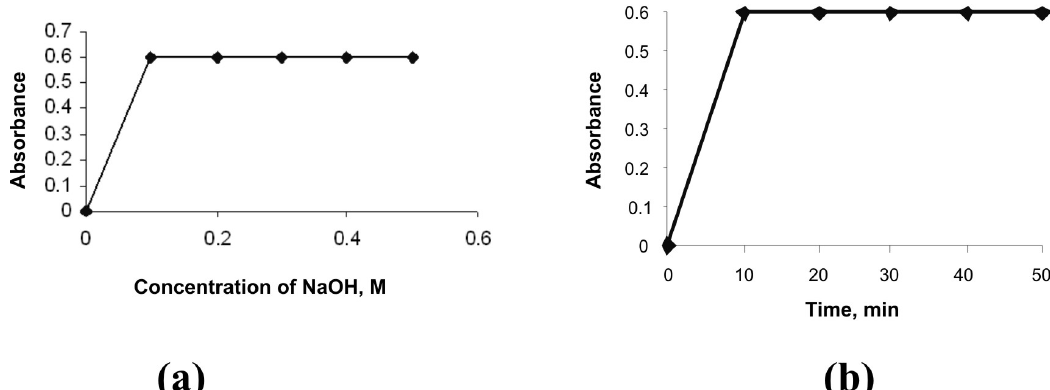
FIGURE 5 - Effect of NaOH concentration and standing time. (a) . Effect of NaOH concentration (6 µg mL -1 OLP). (b) . Effect of reaction time and stability of the coloured species.